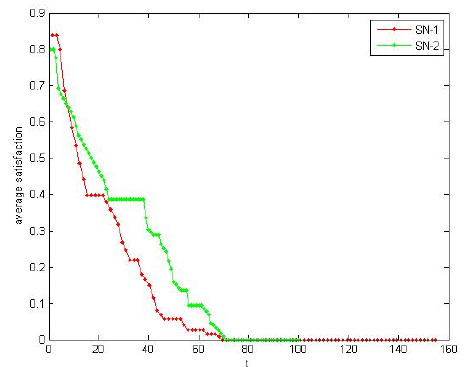
Figure 18. The contrast of adaptive capacity.